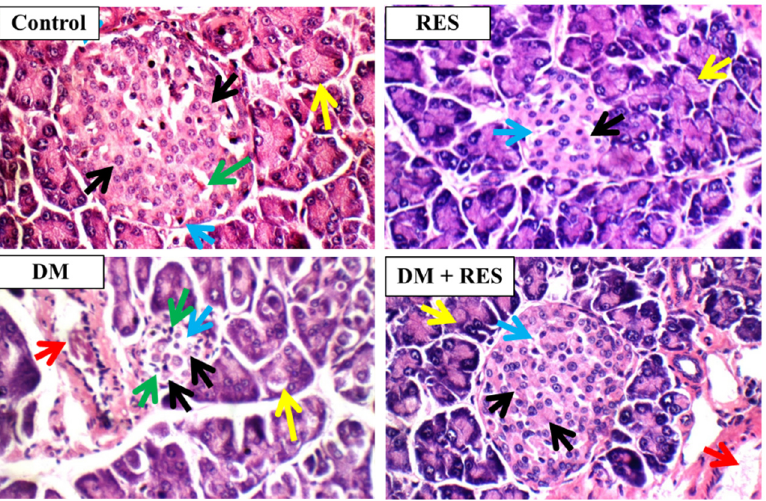
Figure 8. Islets of pancreas from control and RES-injected mice showed average islets, fewer α cells, marginal pink cytoplasm (blue arrows), average dominant thin-wall blood capillaries (green arrows), normal exocrine spaces (yellow arrows), and predominating β -cells with middle-pale-blue cytoplasm (black arrows). Pancreatic tissue of mice treated with STZ shows obvious apoptotic β -cells (black arrows); noticeable dilated principal blood capillaries (blue arrows); inflammatory infiltrate (green arrows); noticeable small-sized hypo-cellular islets, average exocrine zones (yellow arrows); and congested interstitial blood vessels (red arrows). Section from pancreas of mice injected with RES and STZ displays normal-sized islets and a low number of dispersed apoptotic β -cells (black arrows) and normal exocrine spaces (yellow arrows), normal prevailing blood capillaries (blue arrows), and normal blood vessels (red arrows) (H&E × 400).